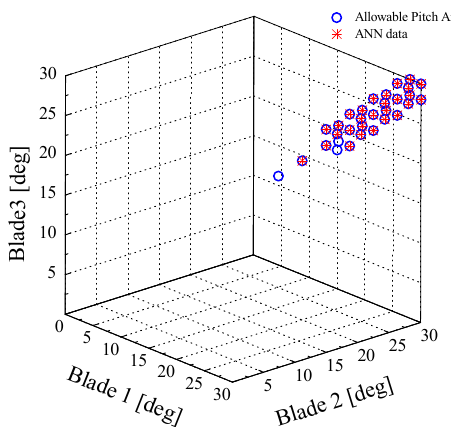
Figure 11. APA and ANN data for M a of 22 m/s.